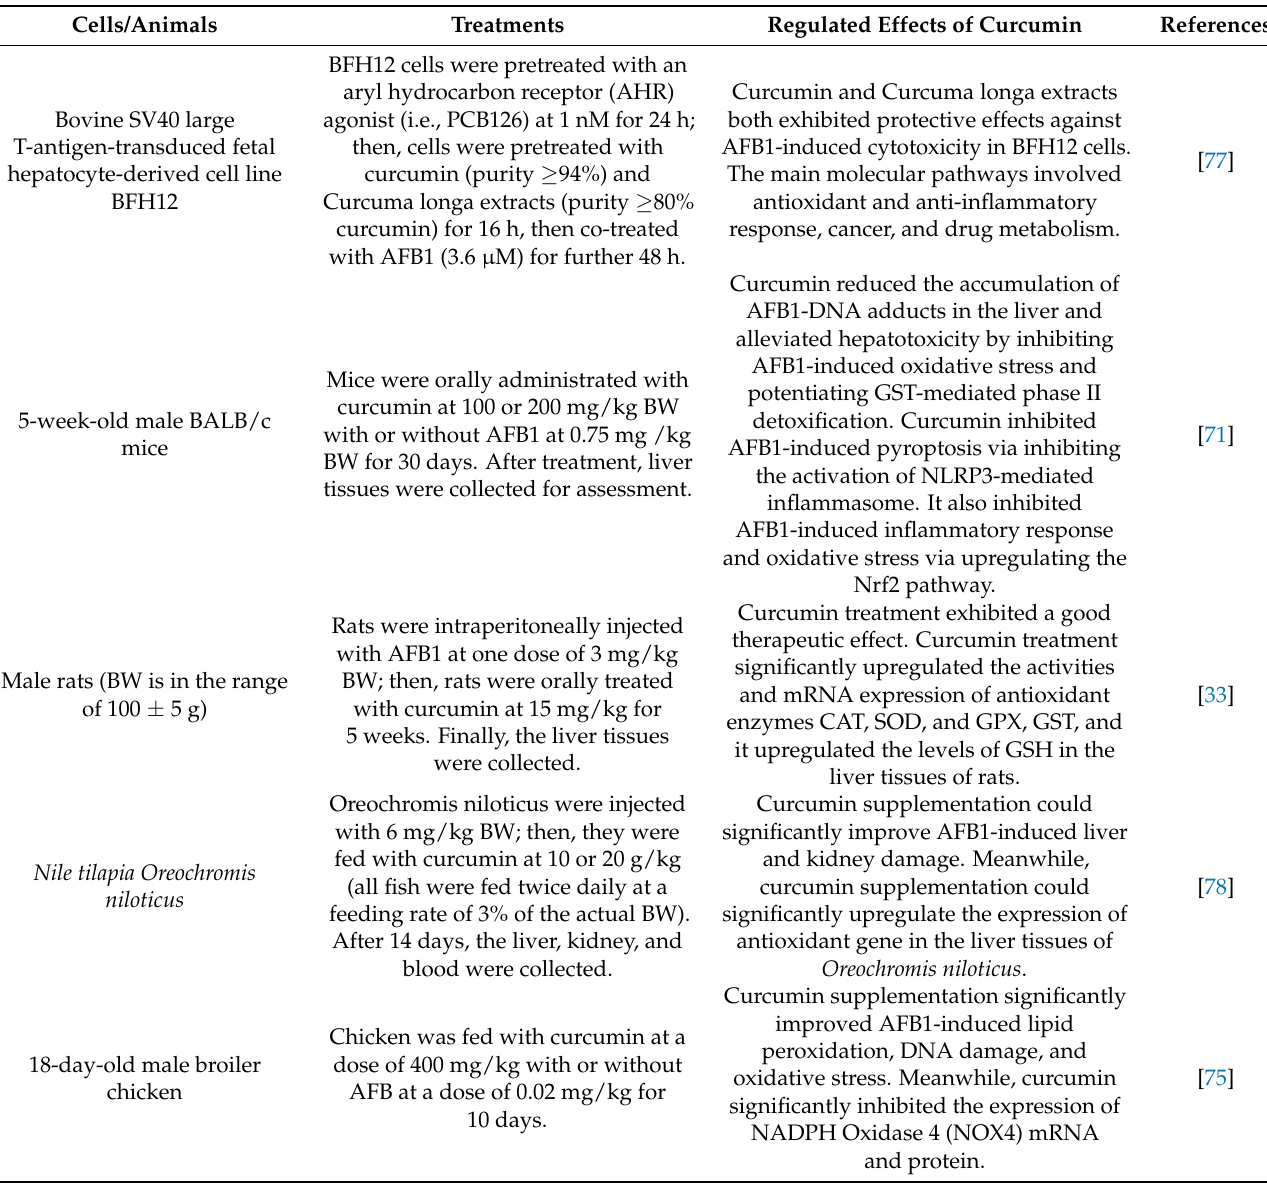
Table 1. A summary of in vitro and animal models involving the protective effects of curcumin or curcuminoids on AFB1-induced